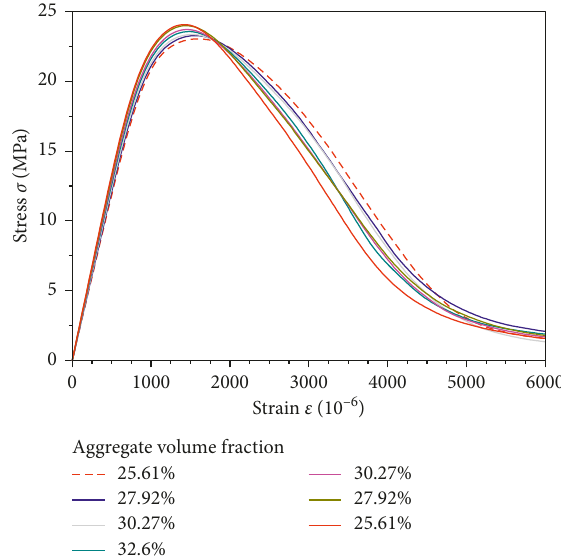
Figure 23: Macrocompressive stress-strain curve of the concrete specimen with different coarse aggregate contents.